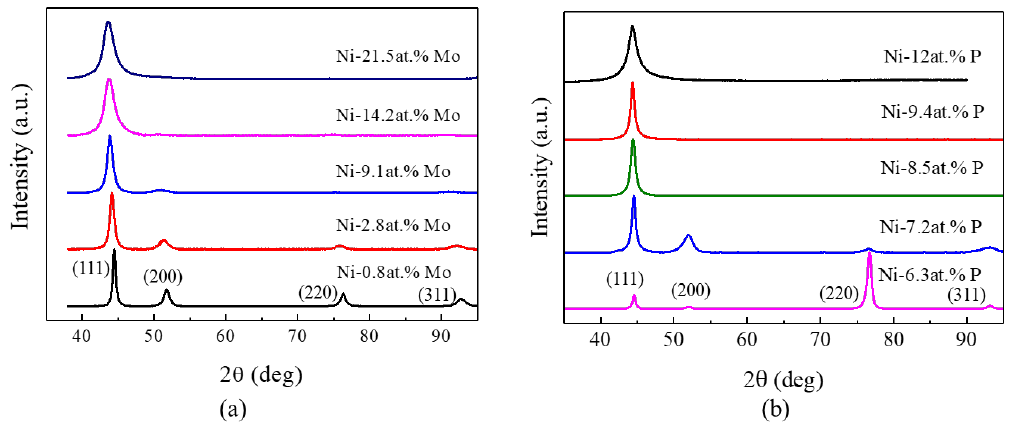
Figure 2. X-ray diffraction patterns of ( a ) ng Ni-Mo alloys with the atomic percentage of Mo varying from 0.8 to 21.5, and of ( b ) ng Ni-P with P from 6.3 to 12.